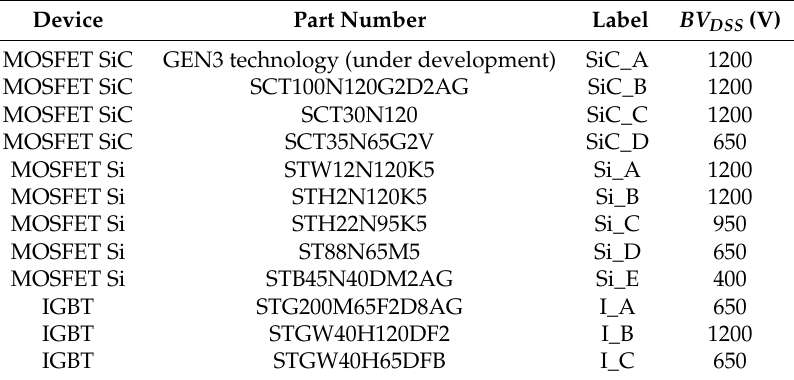
Table 1. List of the tested power devices.